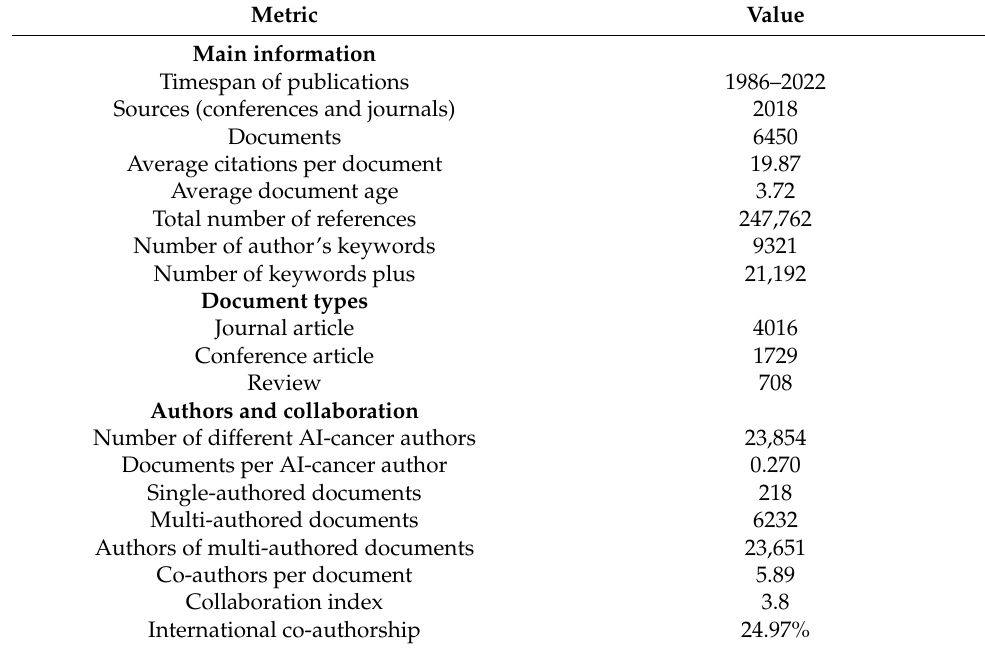
Table 1. Main information and general